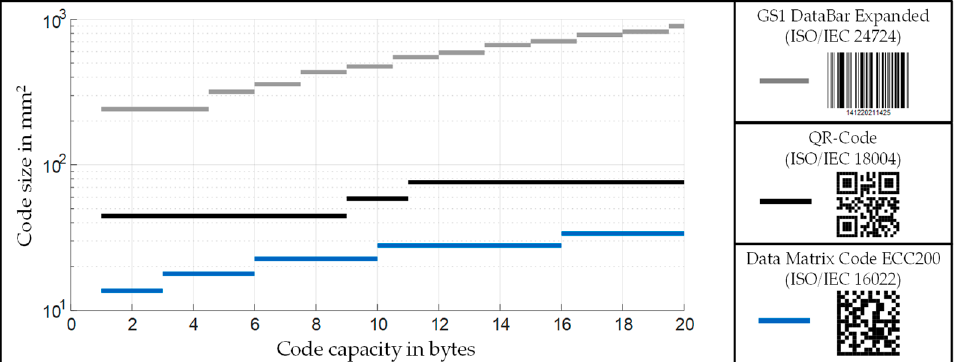
Figure 5. Comparison of the selected code formats (DMC, QR code, and DataBar Expanded code) regarding their storable content and the space required; calculated with a module width of 0.264 mm, which is the recommended module size for GS1 DataBar Expanded [22].